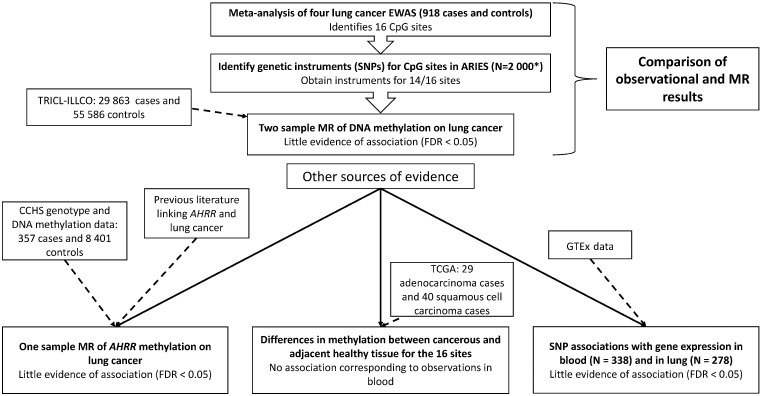
Study design with results summary. ARIES, Accessible Resource for Integrated Epigenomic Studies; TRICL-ILLCO, Transdisciplinary Research in Cancer of the Lung and The International Lung Cancer Consortium; MR, Mendelian randomization; CCHS, Copenhagen City Heart Study; TCGA, The Cancer Genome Atlas. *2 000 individuals with samples at multiple time points.